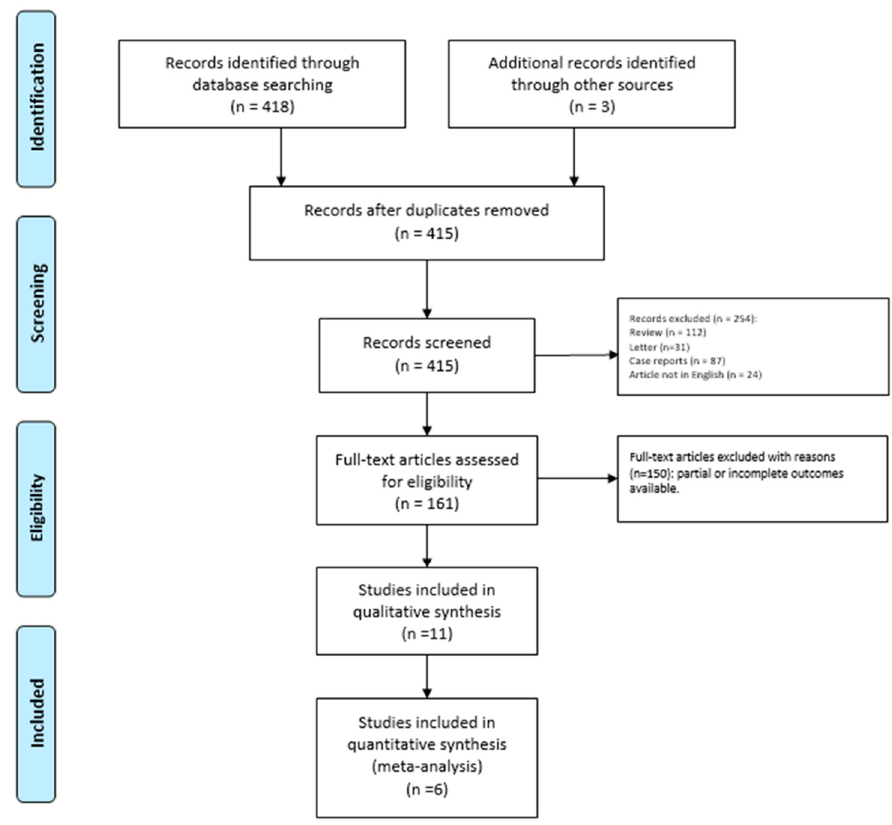
Figure 1. PRISMA Figure 1. PRISMA Flow-diagram.